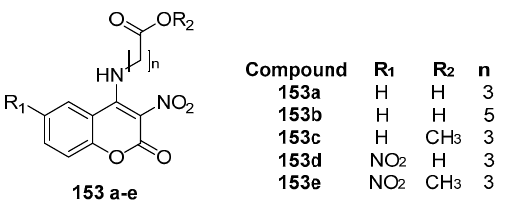
Figure 48. Chemical structure of compounds 153a–e .